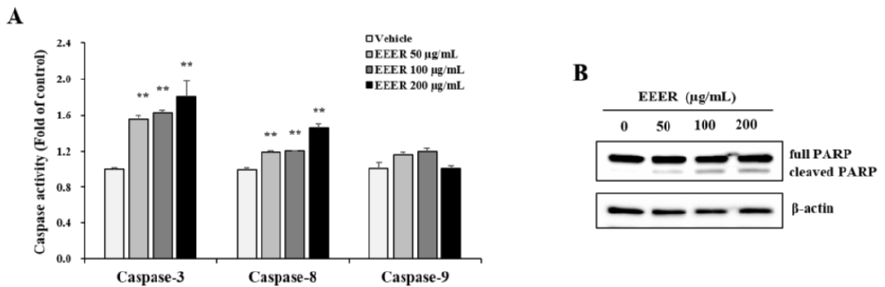
Figure 5. Effect of EEER on caspase activation in BPH-1 cells. ( A ) Caspase-3, caspase-8, and caspase-9 activities. Cytosolic extracts (200 μg) from cells treated with vehicle or EEER for 24 h were subjected